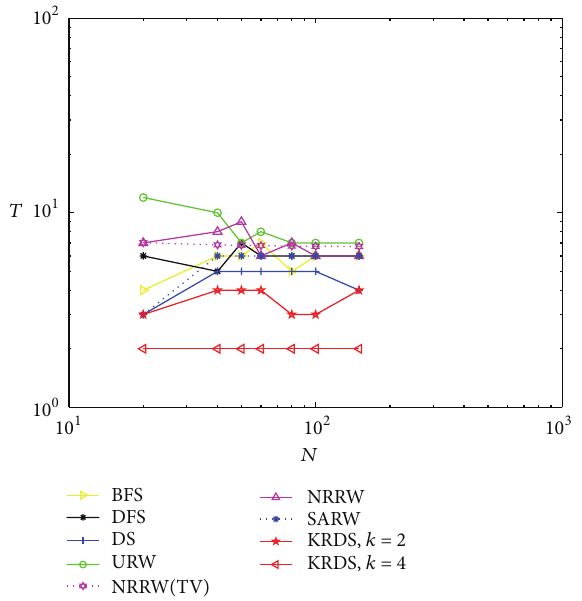
Figure 2: Plot of the average number 𝑇 of the search steps versus the network size 𝑁 of the ERRG with connection probability 𝑝 = 0.15 in the log-log scale.